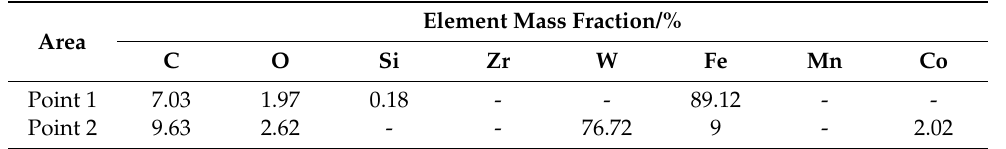
Table 3. The EDS results of Points 1 and 2 in Figure